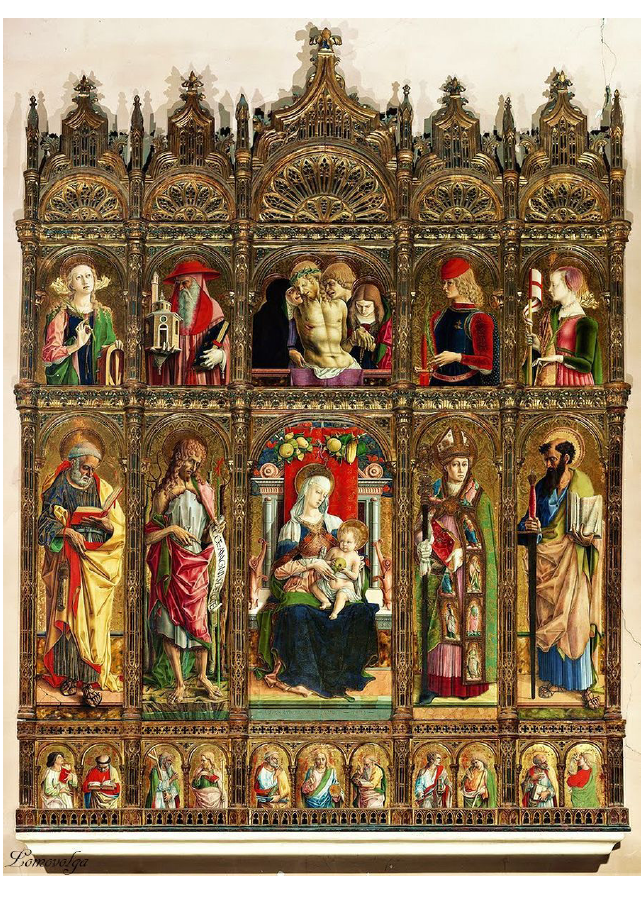
Fig. 5 Carlo Crivelli, Polittico di Sant’Emidio , 1473 (Ascoli Piceno, Cattedrale di